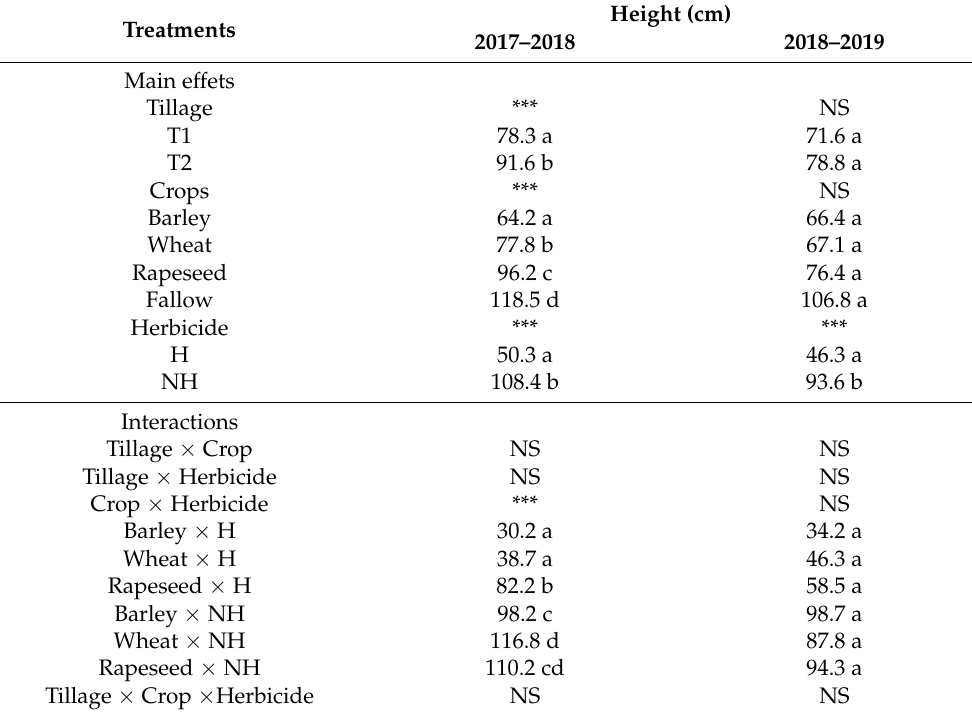
Table 5. Effect of tillage, crops and herbicide application on G. coronaria height (cm) at flowering stage in the two growing seasons. Results of main effect and interactions from a three-way ANOVA are also